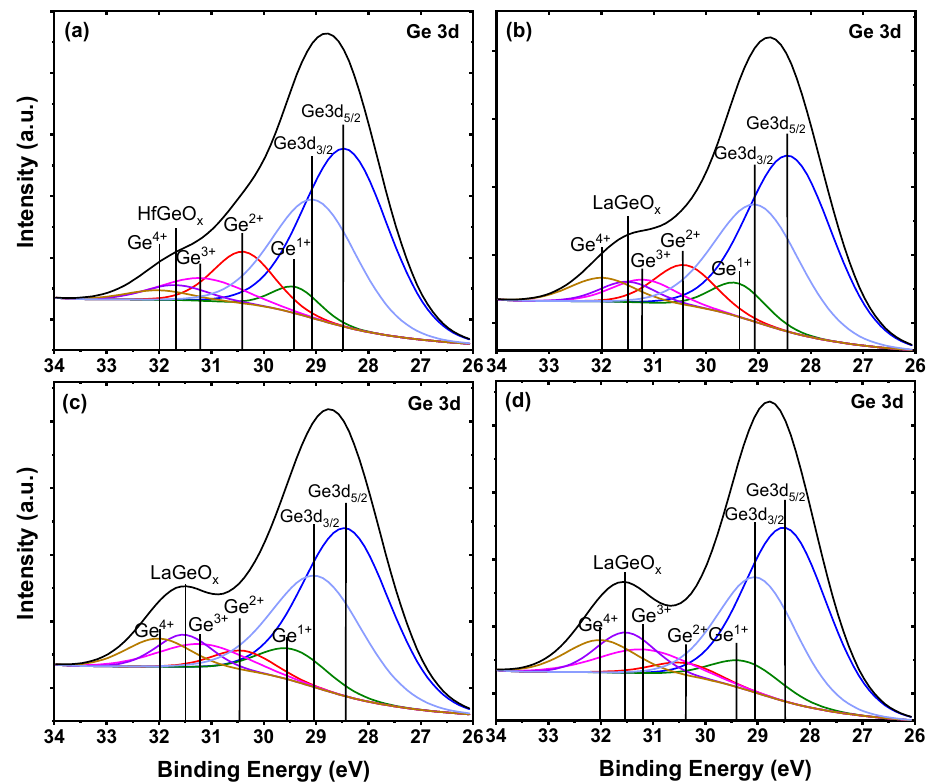
Figure 2. Ge 3d XPS spectra of the deposited gate stacks with di ff erent ALD cycles of La 2 O 3 passivation layer on Ge substrates. ( a ) The control sample; ( b ) 5 ALD cycles of La 2 O 3 passivation layer; ( c ) 10 ALD cycles of La 2 O 3 passivation layer; and ( d ) 15 ALD cycles of La 2 O 3 passivation layer.